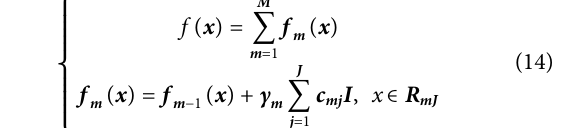
TABLE 4 | The outlier detection results in simulated scenarios.